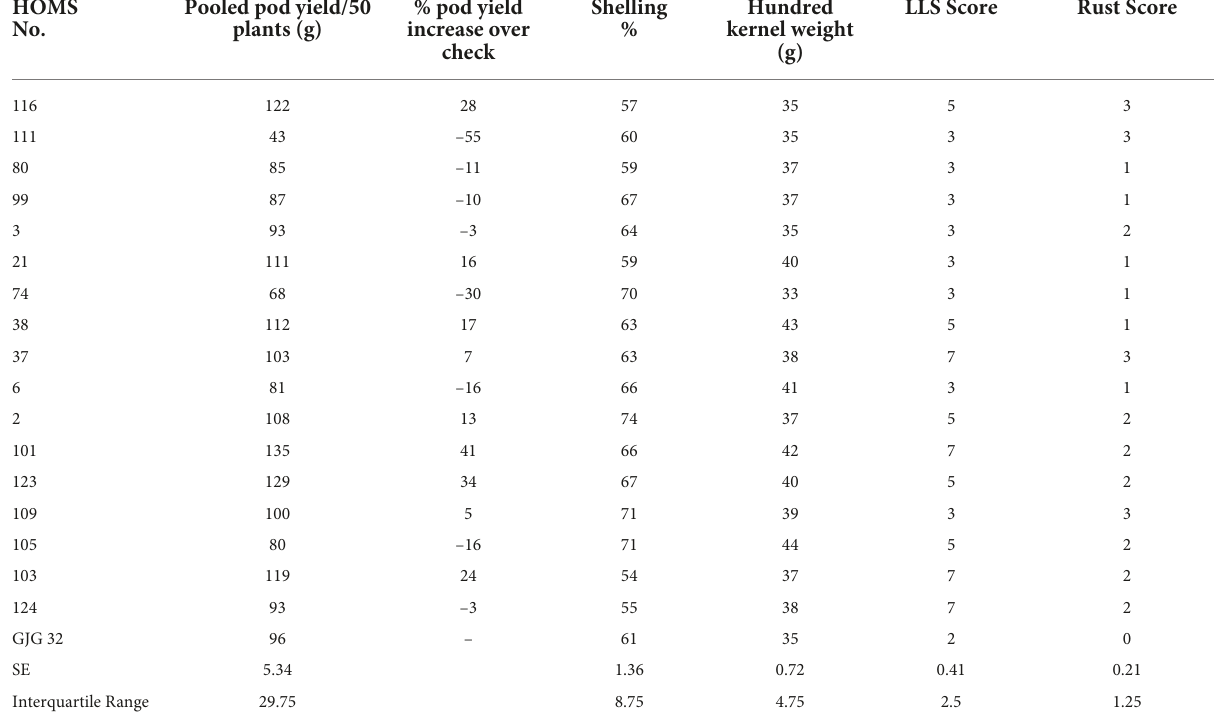
TABLE 3 Pod yield of Spanish bunch (SB) high oleic breeding lines, percent increase of pod yield over check, shelling% and hundred kernels weight in the rainy season. HOMS No.